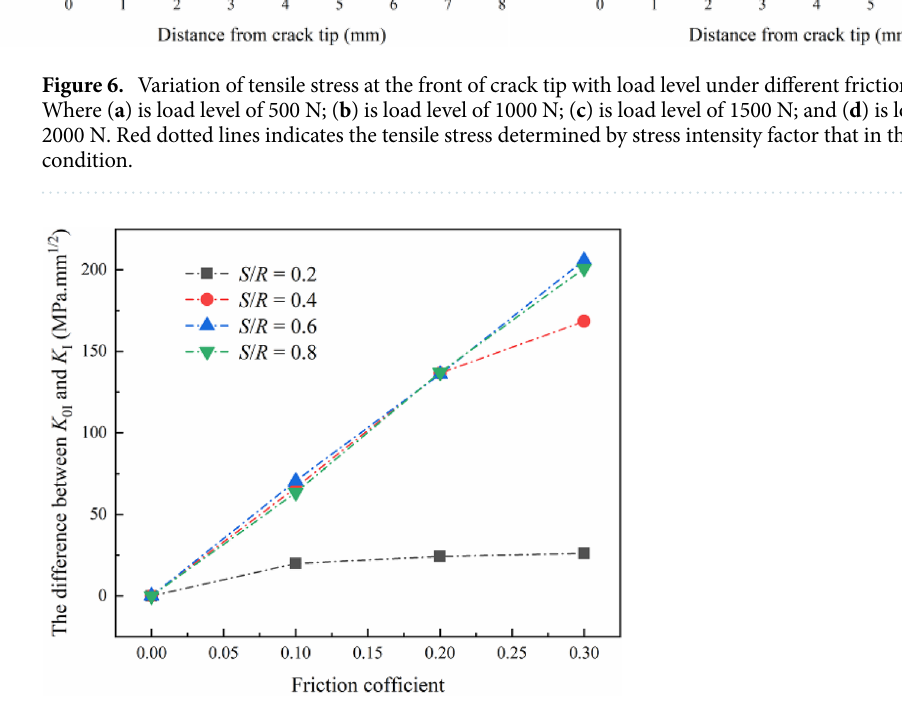
Figure 7. The decrease of stress intensity factor under different span of roller support varies with the friction